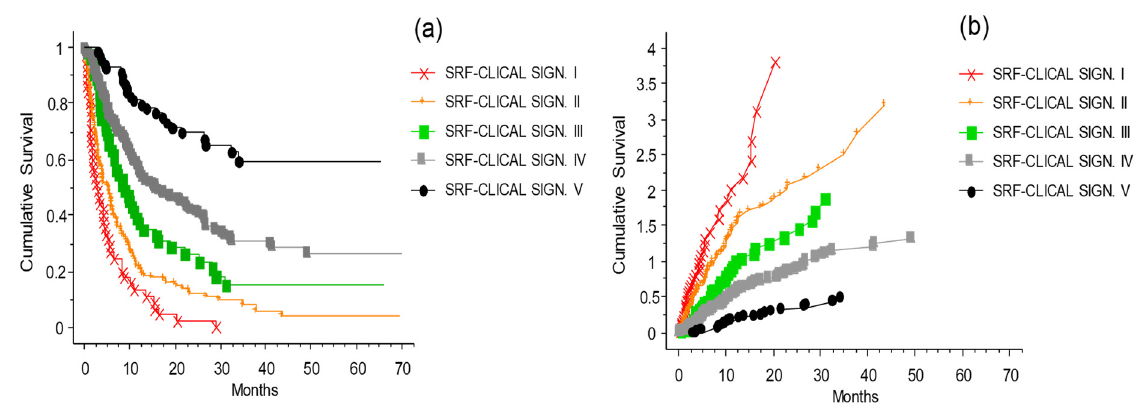
Figure 13. Kaplan–Meier survival curves of the melanoma patients divided into five risk groups based on their survival probability predictions obtained using the optimized survival random forest model. Plot ( a ) shows the cumulative survival with the distribution of the patients grouped by their signatures (applied to the risk groups defined by the SRF-CLICAL). The five curves are significantly separated from one another ( p < 0.0001). ( b ) The presentation of the cumulative risks for each signature easily shows whether the characteristics of each signature are favorable or not.